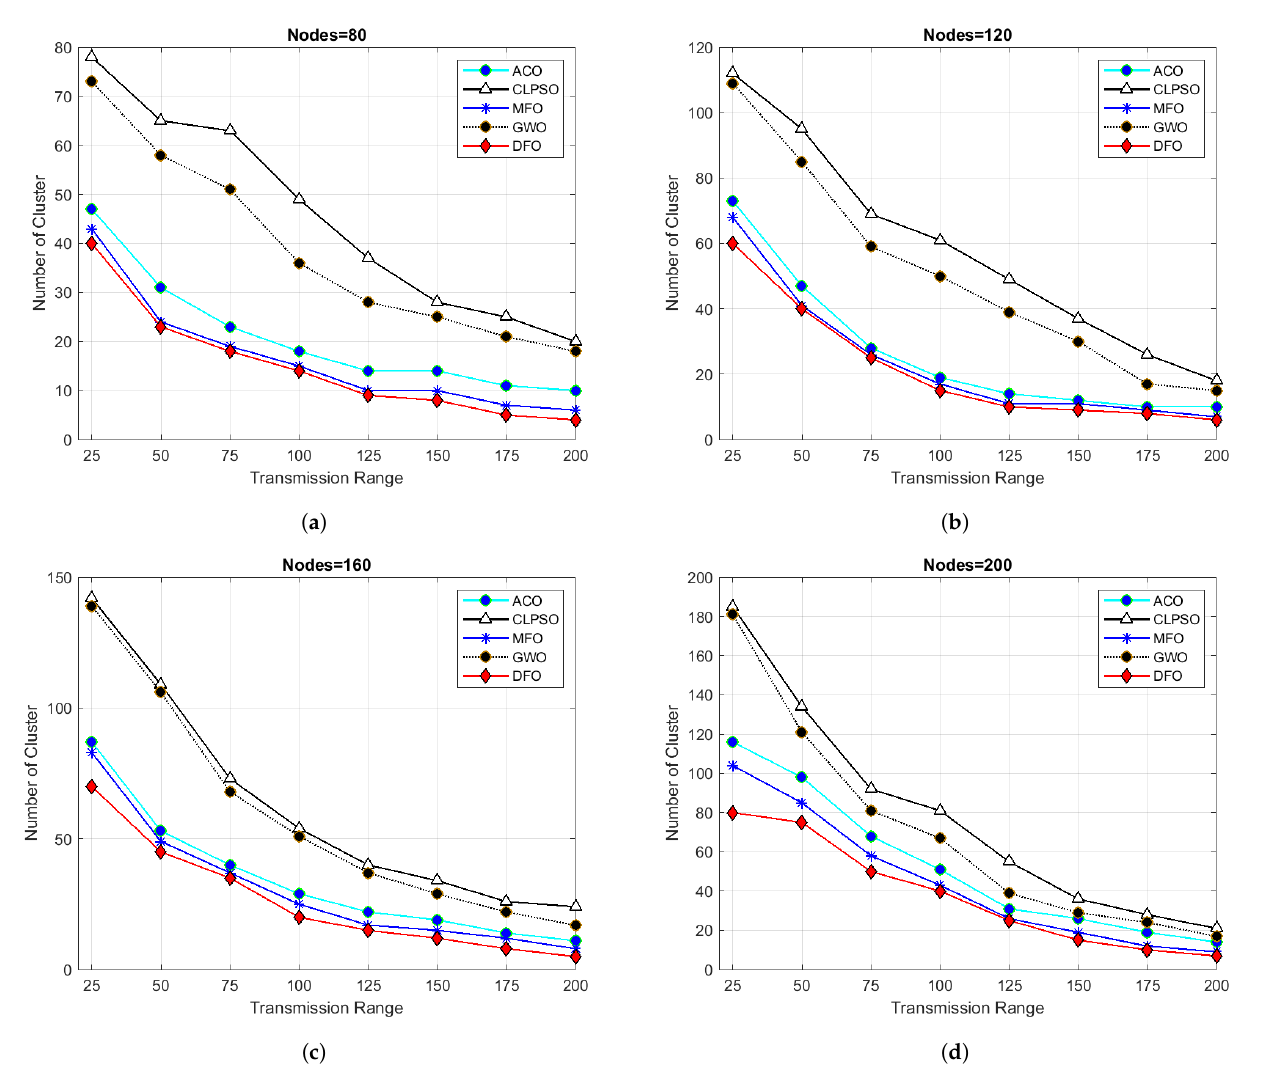
Figure 10. Grid size 1500 m × 1500 m and transmission range from 25 to